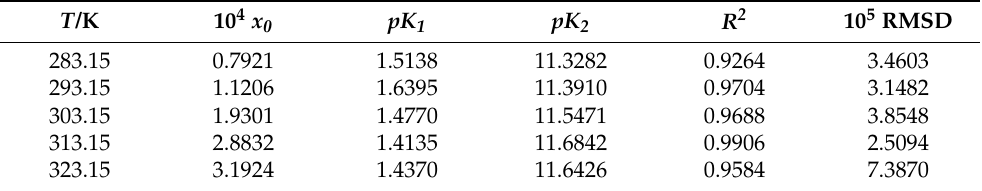
Table 5. Tsuji equation fitting parameters for the solubility of phenylglycine in water affected by pH.